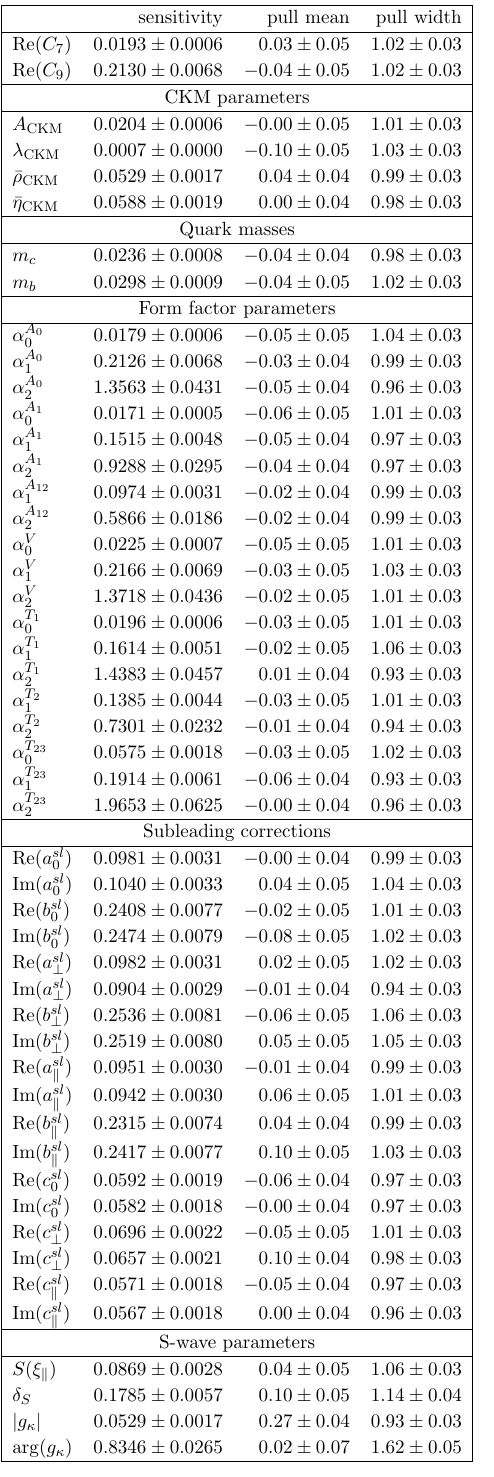
Table 8. Results from pseudoexperiments determining Re( C 7 ) and Re( C 9 ) using (left) the proposed direct (cid:12)t method and (right) the q 2 -binned approach.